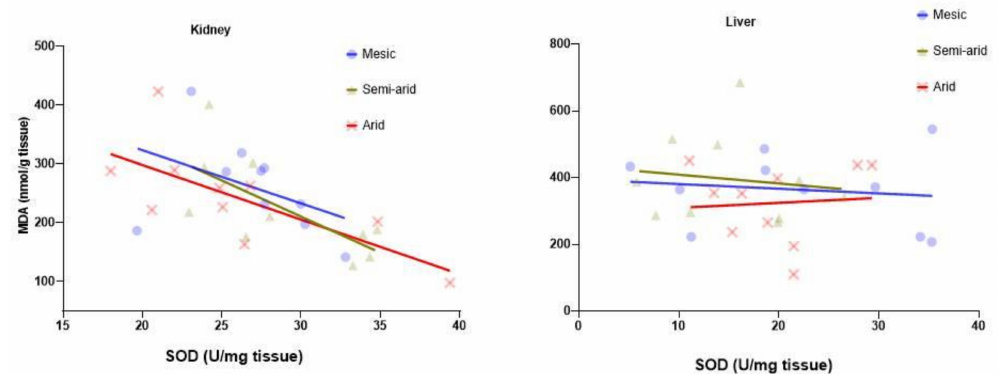
Figure 5. Correlations between malondialdehyde (MDA—nmol/g tissue) and superoxide dismutase (SOD—U/mg tissue) activity in the kidney and liver of the common mole-rat ( Cryptomys hottentotus hottentotus ) for each population along an aridity gradient (arid—red (circles), semi-arid—moss (triangle), mesic—blue (x)). Kidney—arid: r = − 0.71, p = 0.02; semi-arid: r = − 0.69, p = 0.03; mesic: ( r = − 0.42, p = 0.22. Liver—arid: r = 0.08, p = 0.84; semi-arid: r = − 0.13, p = 0.71; mesic: r = − 0.14, p =